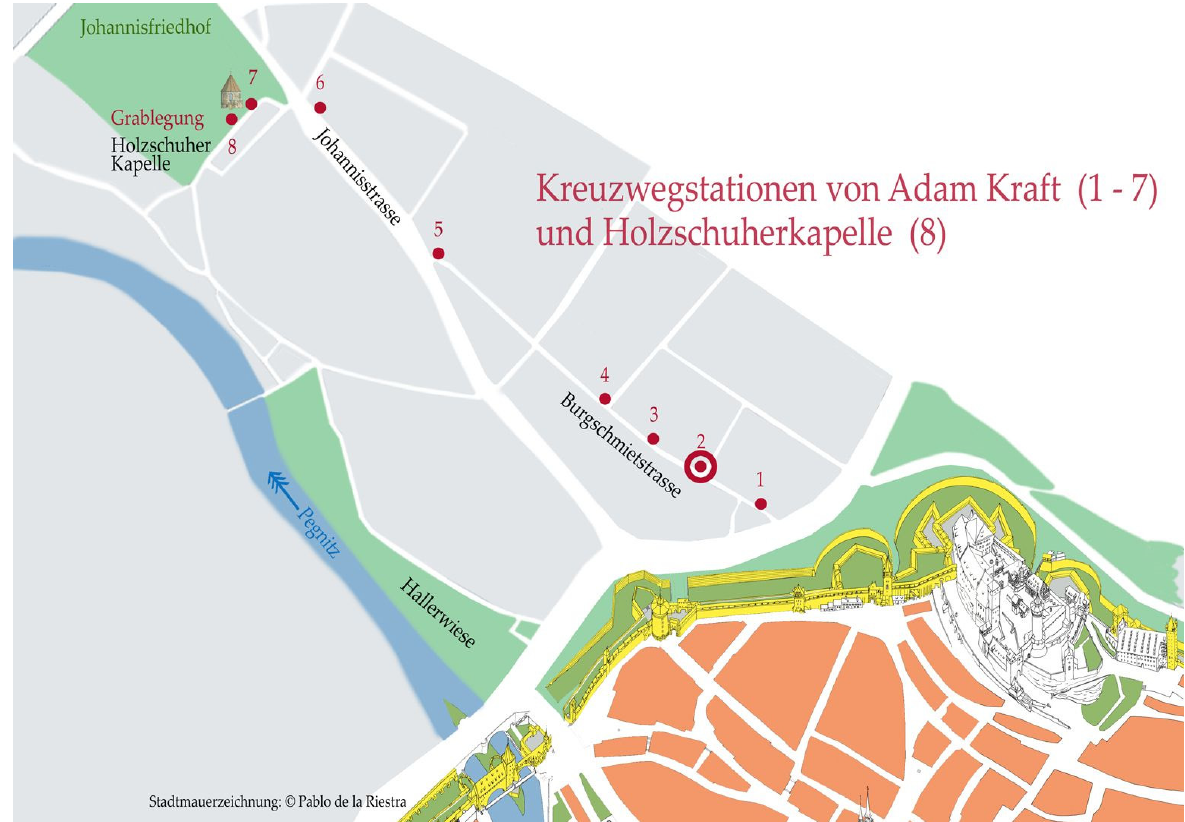
Figure 14. Map of Kraft, Stations of the Cross, 1506–1508 in Nuremberg.